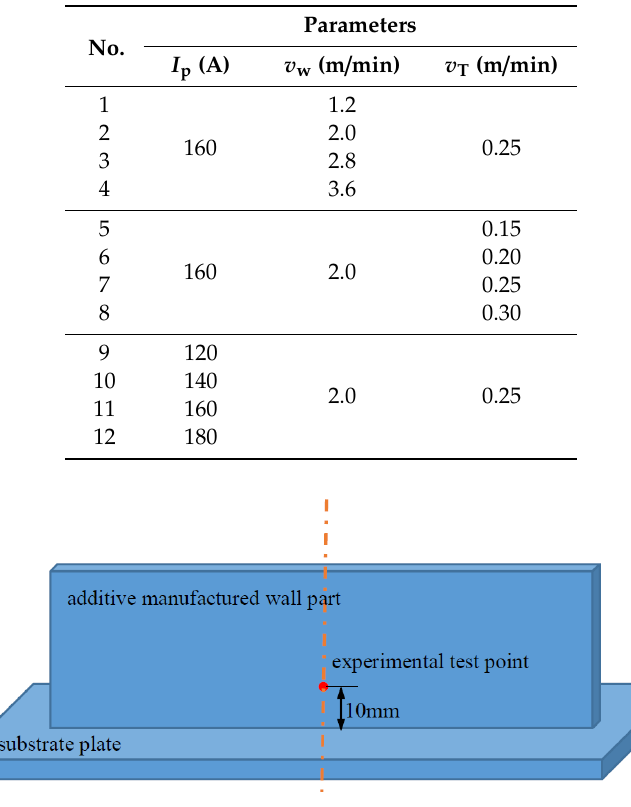
Figure 1. Schematic drawing of the experimental test position. Table 2. Variable design for thermal boundary investigation.